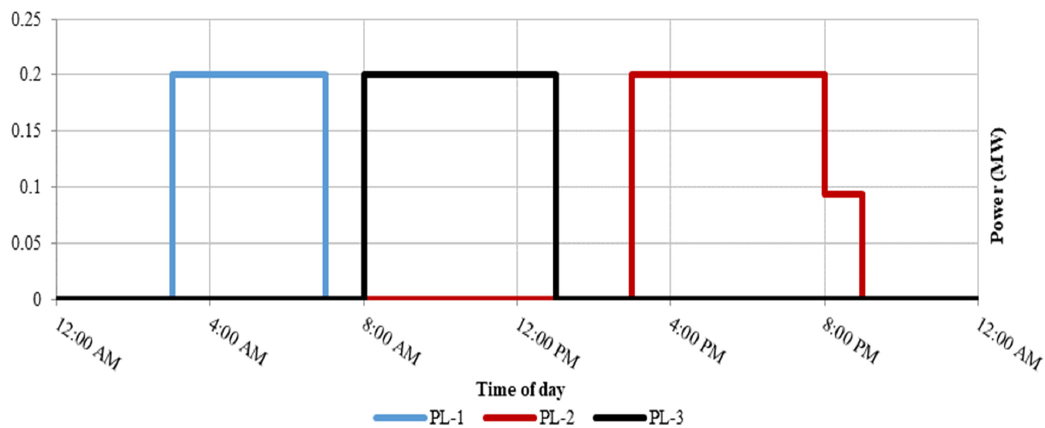
Figure 8. Case study 2-MESS discharging rate.